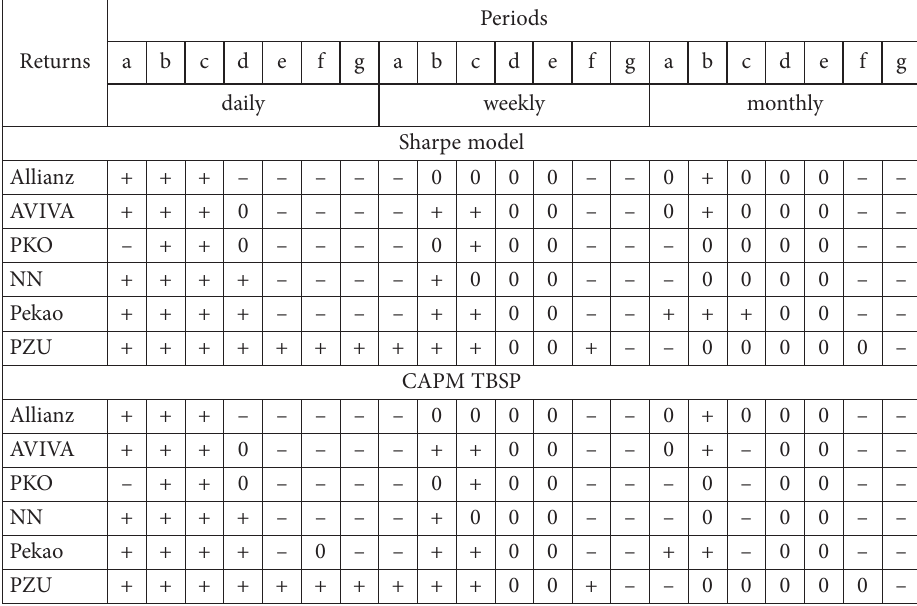
Table 11. Decision based on statistics (5) for equality of betas estimated for the pension and mutual funds in all periods; H 0 : β OFE = β FIO (source: own